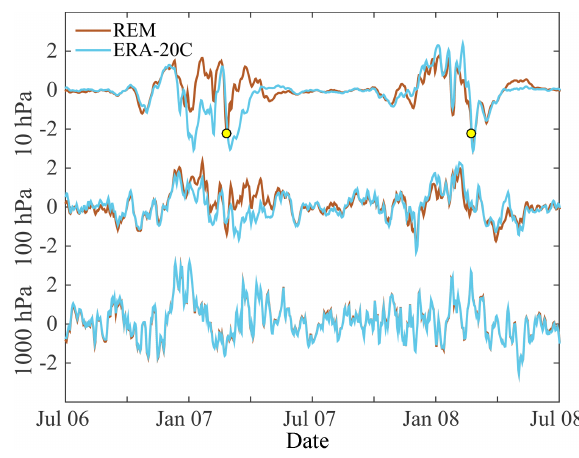
Figure 8. Comparison between the Northern Annular Mode time series from the reanalysis ensemble mean (REM) and ERA-20C at 10, 100, and 1000hPa over a 2-year period, 1 July 2006 to 1 July 2008. Yellow dots indicate the occurrence of two sudden strato- spheric warming events during this